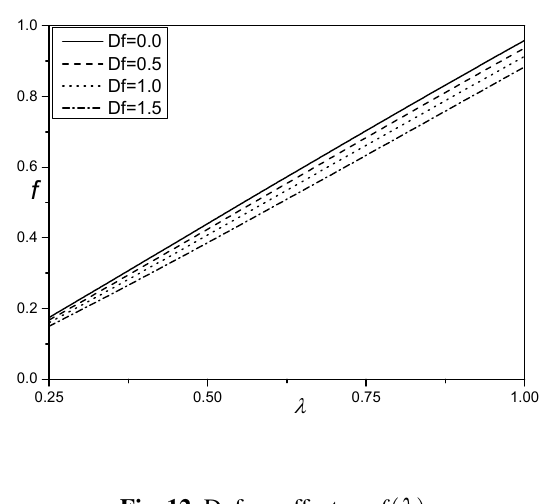
Fig. 12 Dufour effect on f ( λ